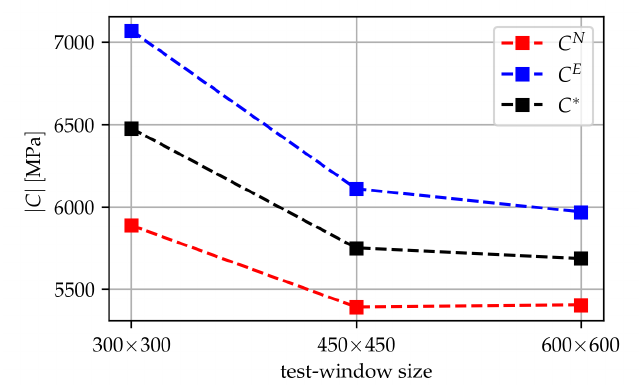
Figure 15. Frobenius norm of the estimates for C E , C N and C Hom for different size of